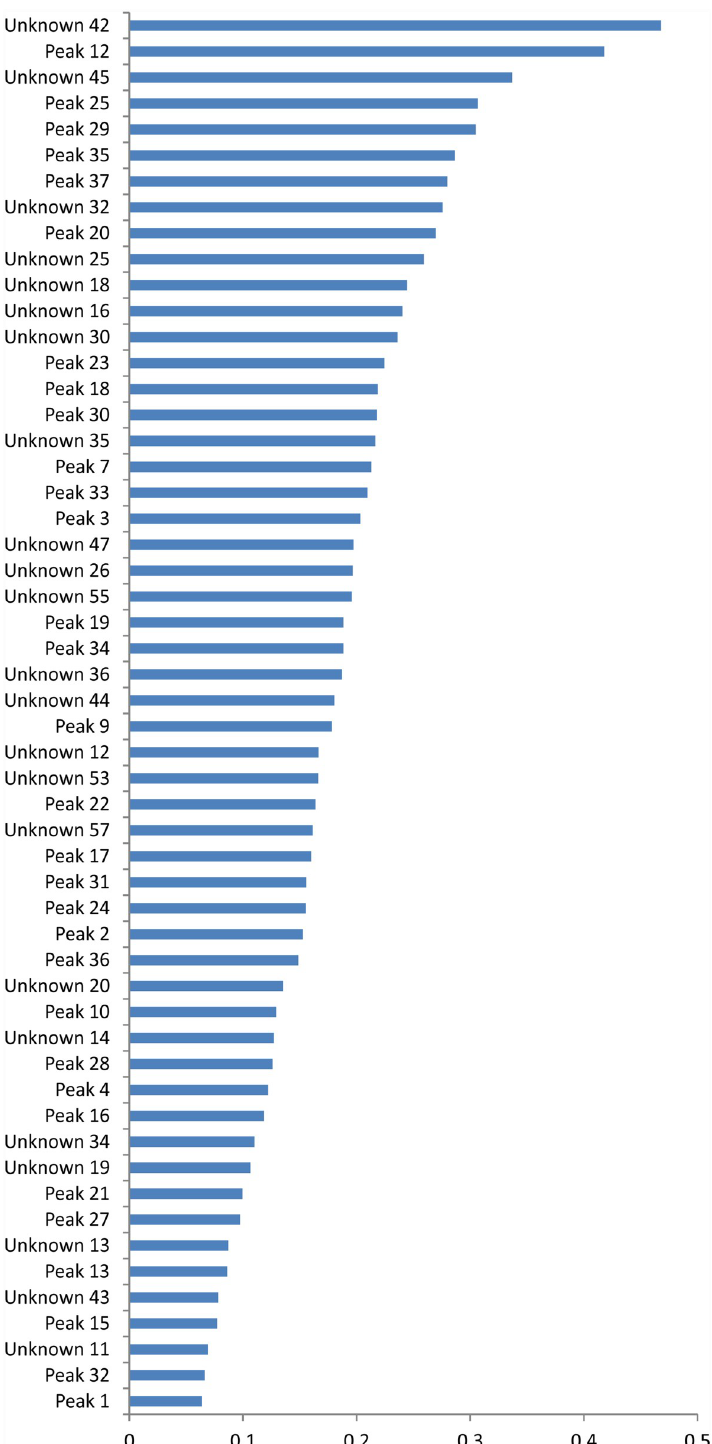
Fig 2. Correlation between secondary metabolites represented by peak observed in mass spectrometry and biological activity of extracts of origin characterized based on EC 90 .